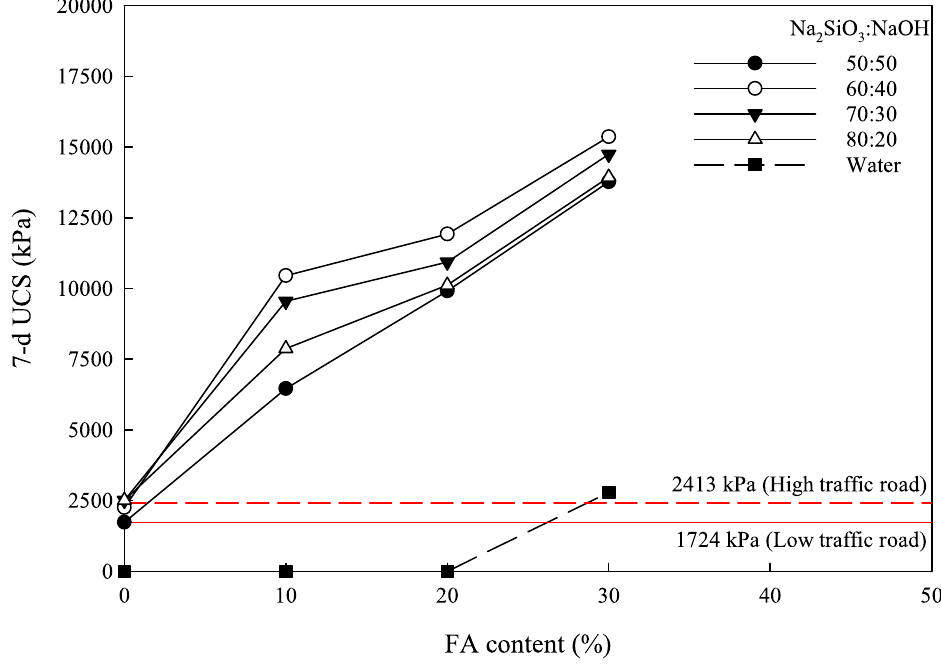
Figure 3. The 7-d UCS of RCA-FAG